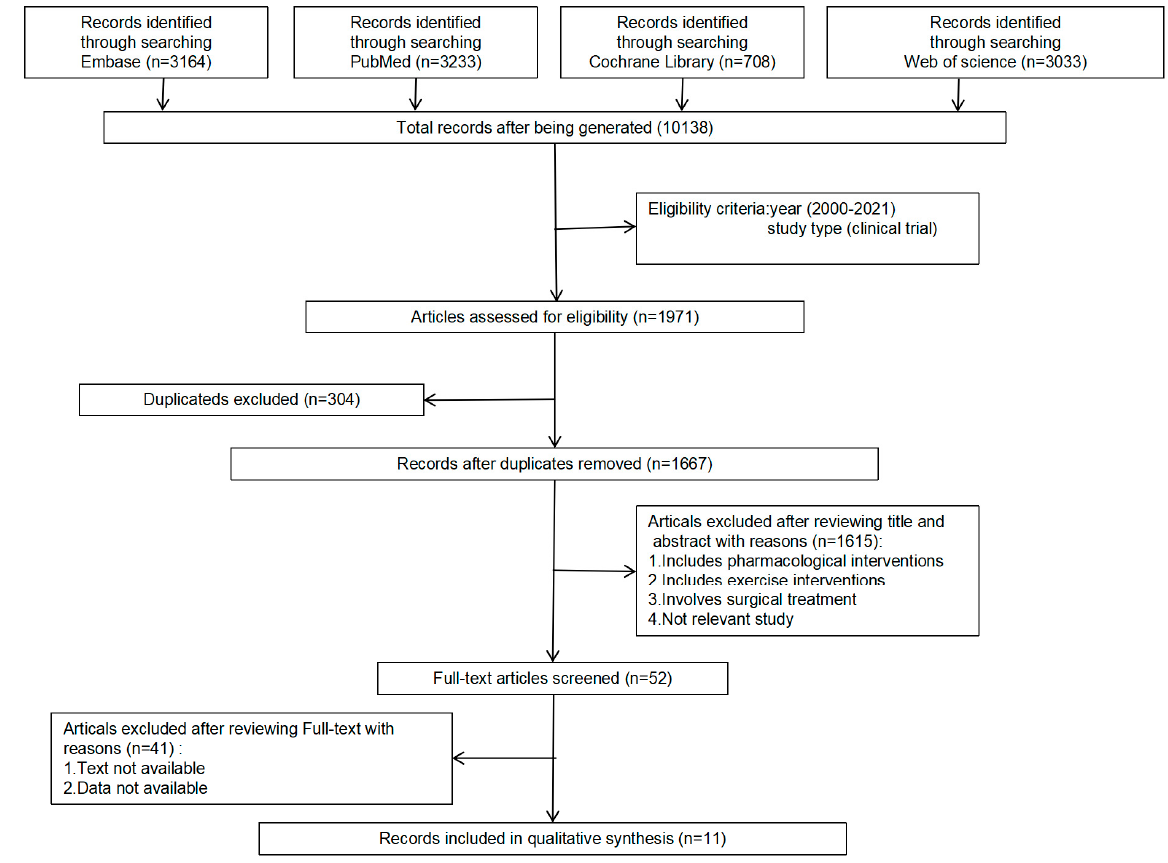
Figure 1. Flow chart of literature